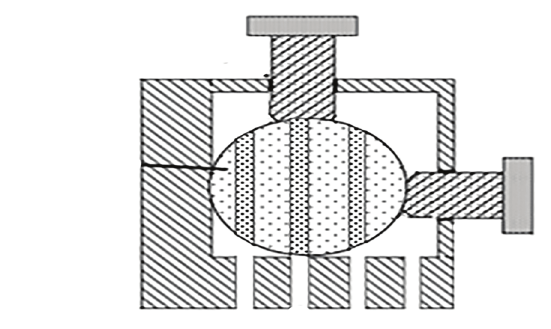
Figure 4 - Sectional view of a device for bone allograft channeling with subsequent impregnation of drugs into the bone tissue with a fixed